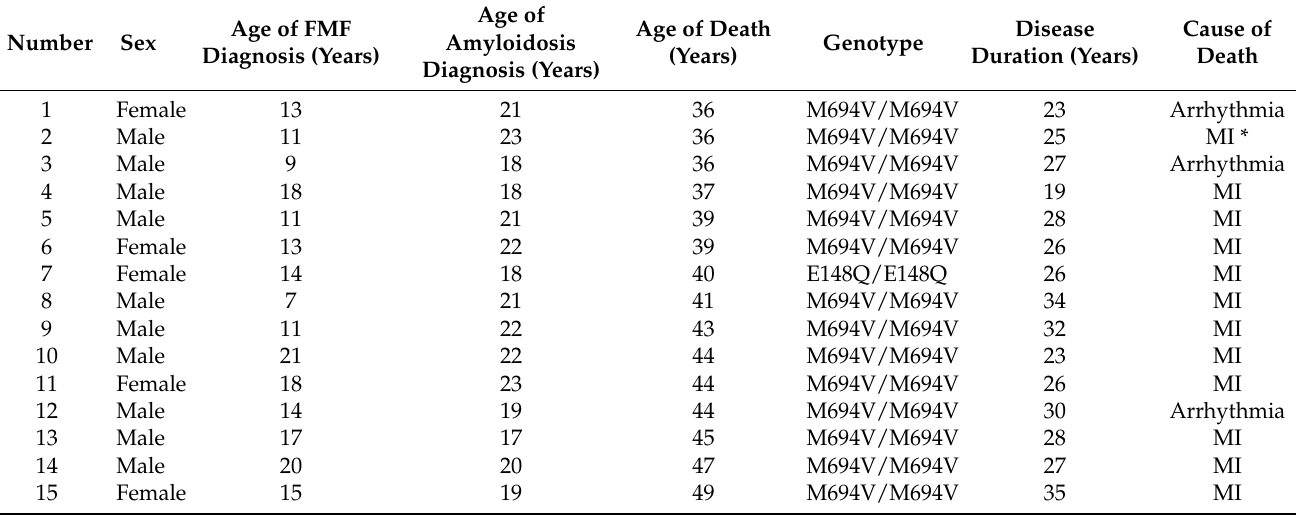
Table 3. Characteristics of patients who died during the follow-up